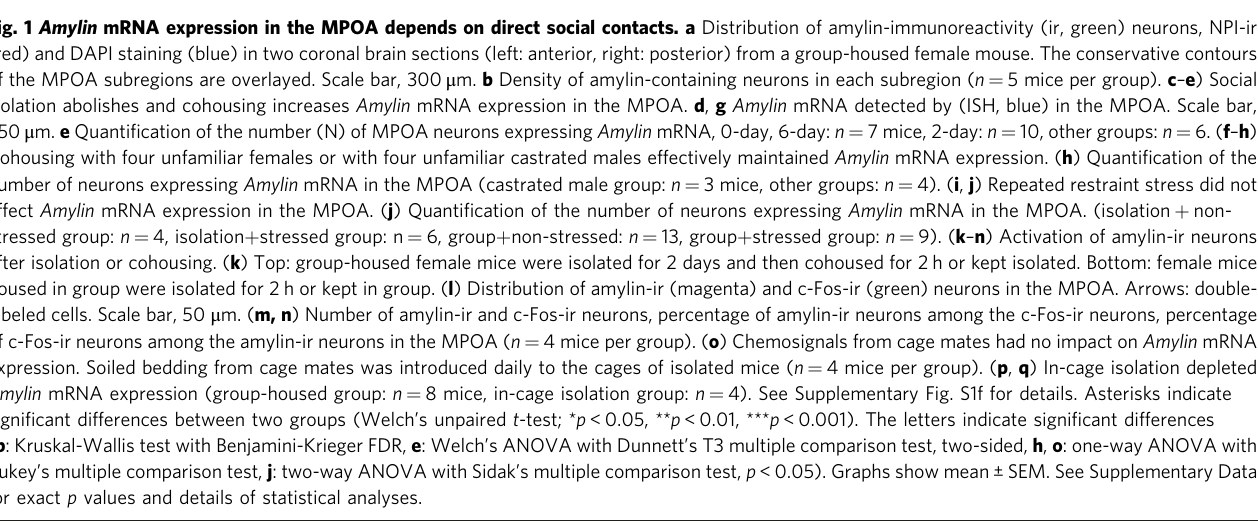
Fig. 1 Amylin mRNA expression in the MPOA depends on direct social contacts. a Distribution of amylin-immunoreactivity (ir, green) neurons, NPI-ir (red) and DAPI staining (blue) in two coronal brain sections (left: anterior, right: posterior) from a group-housed female mouse. The conservative contours of the MPOA subregions are overlayed. Scale bar, 300 μ m. b Density of amylin-containing neurons in each subregion ( n = 5 mice per group). c – e ) Social isolation abolishes and cohousing increases Amylin mRNA expression in the MPOA. d , g Amylin mRNA detected by (ISH, blue) in the MPOA. Scale bar, 250 μ m. e Quanti fi cation of the number (N) of MPOA neurons expressing Amylin mRNA, 0-day, 6-day: n = 7 mice, 2-day: n = 10, other groups: n = 6. ( f – h ) Cohousing with four unfamiliar females or with four unfamiliar castrated males effectively maintained Amylin mRNA expression. ( h ) Quanti fi cation of the number of neurons expressing Amylin mRNA in the MPOA (castrated male group: n = 3 mice, other groups: n = 4). ( i , j ) Repeated restraint stress did not affect Amylin mRNA expression in the MPOA. ( j ) Quanti fi cation of the number of neurons expressing Amylin mRNA in the MPOA. (isolation + non- stressed group: n = 4, isolation + stressed group: n = 6, group + non-stressed: n = 13, group + stressed group: n = 9). ( k – n ) Activation of amylin-ir neurons after isolation or cohousing. ( k ) Top: group-housed female mice were isolated for 2 days and then cohoused for 2 h or kept isolated. Bottom: female mice housed in group were isolated for 2 h or kept in group. ( l ) Distribution of amylin-ir (magenta) and c-Fos-ir (green) neurons in the MPOA. Arrows: double- labeled cells. Scale bar, 50 μ m. ( m, n ) Number of amylin-ir and c-Fos-ir neurons, percentage of amylin-ir neurons among the c-Fos-ir neurons, percentage of c-Fos-ir neurons among the amylin-ir neurons in the MPOA ( n = 4 mice per group). ( o ) Chemosignals from cage mates had no impact on Amylin mRNA expression. Soiled bedding from cage mates was introduced daily to the cages of isolated mice ( n = 4 mice per group). ( p , q ) In-cage isolation depleted Amylin mRNA expression (group-housed group: n = 8 mice, in-cage isolation group: n = 4). See Supplementary Fig. S1f for details. Asterisks indicate signi fi cant differences between two groups (Welch ’ s unpaired t -test; * p < 0.05, ** p < 0.01, *** p < 0.001). The letters indicate signi fi cant differences ( b : Kruskal-Wallis test with Benjamini-Krieger FDR, e : Welch ’ s ANOVA with Dunnett ’ s T3 multiple comparison test, two-sided, h , o : one-way ANOVA with Tukey ’ s multiple comparison test, j : two-way ANOVA with Sidak ’ s multiple comparison test, p < 0.05). Graphs show mean ± SEM. See Supplementary Data for exact p values and details of statistical